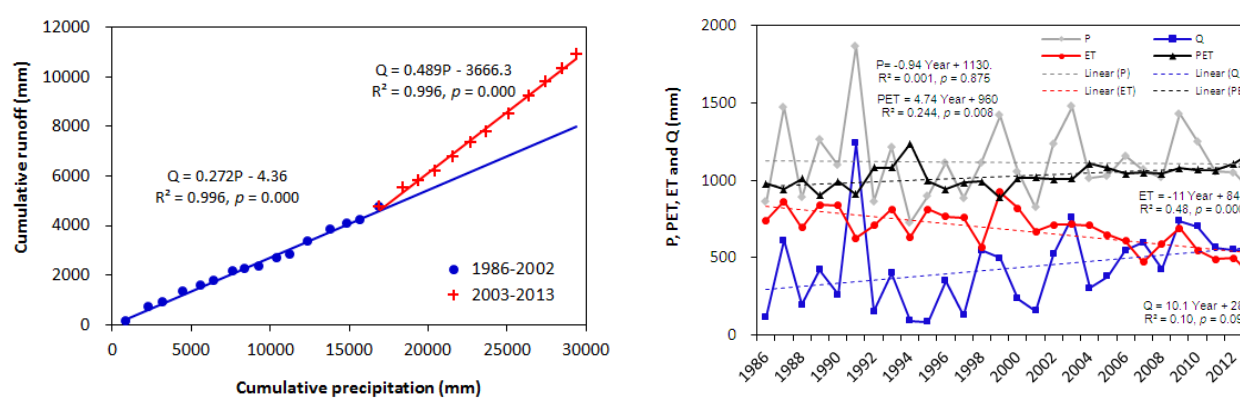
Figure 11. Double mass curves showing the relationships between accumulated annual precipitation ( P ) and total stream flow ( Q ) for the Qinhuai River basin (1986–2013). The extreme wet year of 1991 was removed from the analysis.